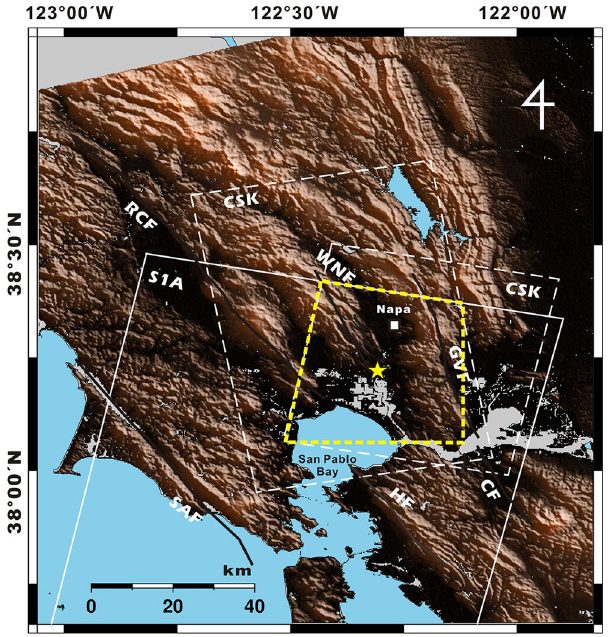
Figure 1. Shaded relief map of the South Napa earthquake region. Thick lines indicate the major faults in the area: SAF, San Andreas Fault; RCF, Rodgers Creek Fault; WNF, West Napa Fault; GVF, Green Valley Fault; CF, Concord Fault; HF, Hayward Fault. The city of Napa and the epicentre are shown as a small square and star, respectively. White rectangles with dashed and solid lines show the frames of COSMO-SkyMed (CSK) and Sentinel-1A (S1A) SAR images, respectively. 3D displacements were retrieved for the areas overlapped by all data frames (yellow dashed line). The map was generated by using the generic mapping tools (GMT)